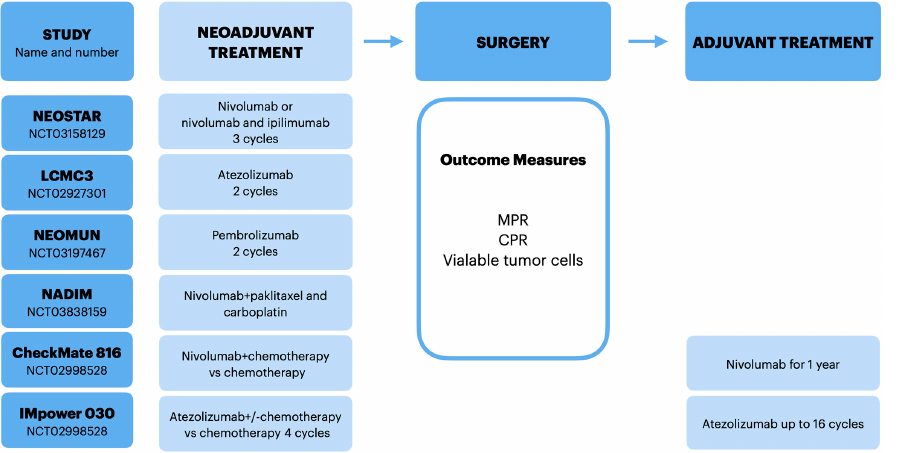
Figure 1. The use of neoadjuvant immunotherapy in NSCLC patients